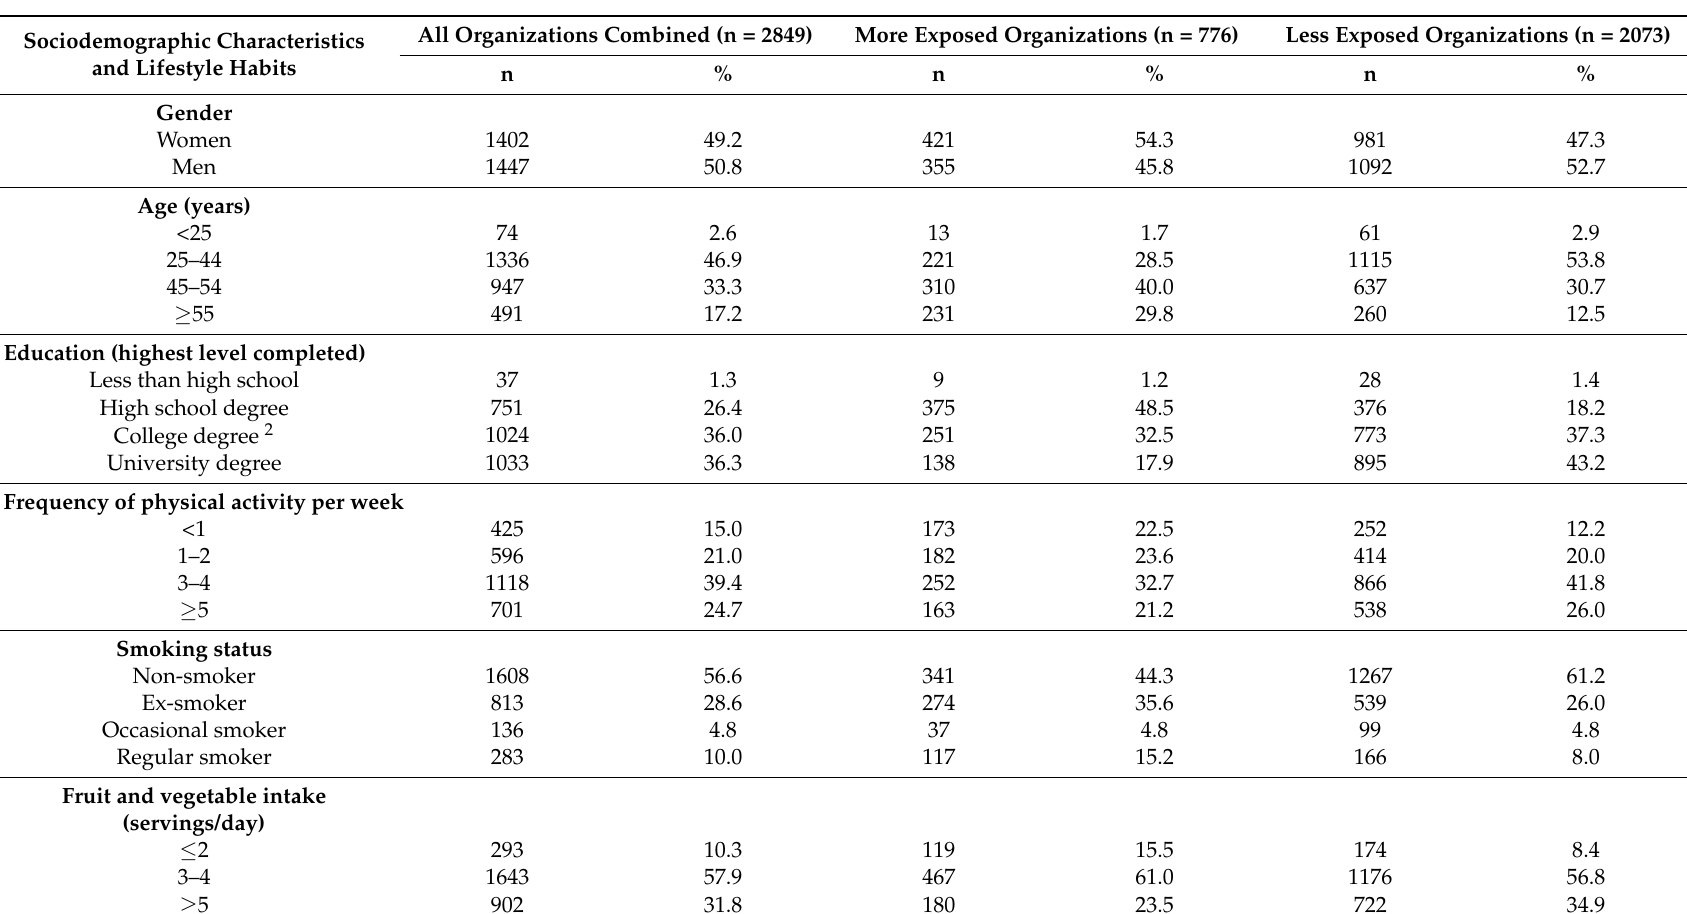
Table 1. Sociodemographic characteristics and lifestyle habits of the study population before QHES 1 implementation (T1), for all organizations combined and by organizations’ exposure to interventions in the Management Practices area of the QHES 1